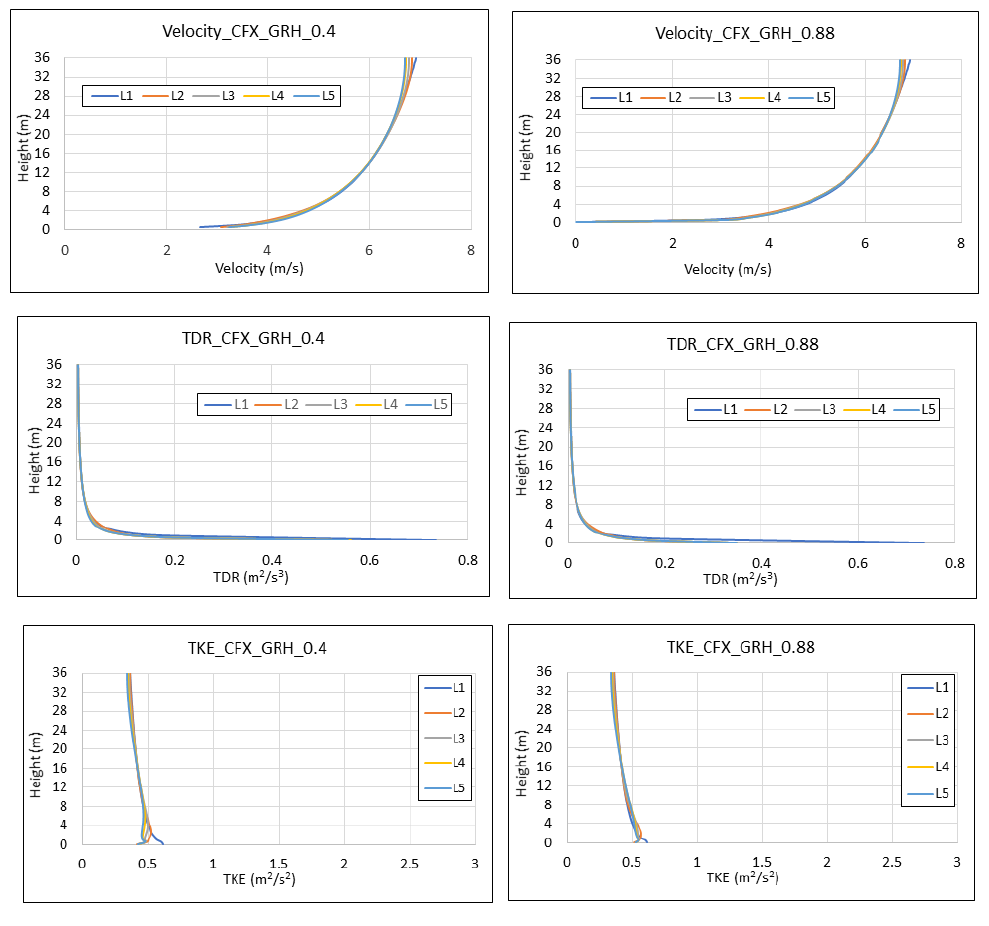
Figure 8. Case 2: Effect of ground roughness height Z s on: turbulent streamwise velocity, u; turbulent kinetic energy (TKE); and turbulent dissipation rate ( ε ) using the CFX software. Left column plots is based on Z s = 0.4 m. Right column of plots is based on Z s = 0.88 m.